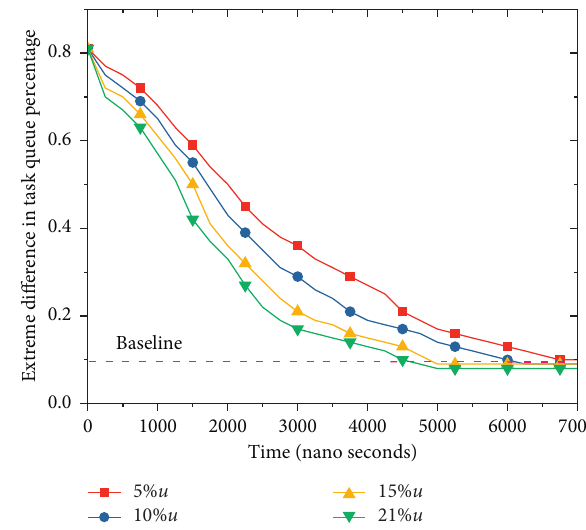
Figure 7: The optimum distance length versus time and B .